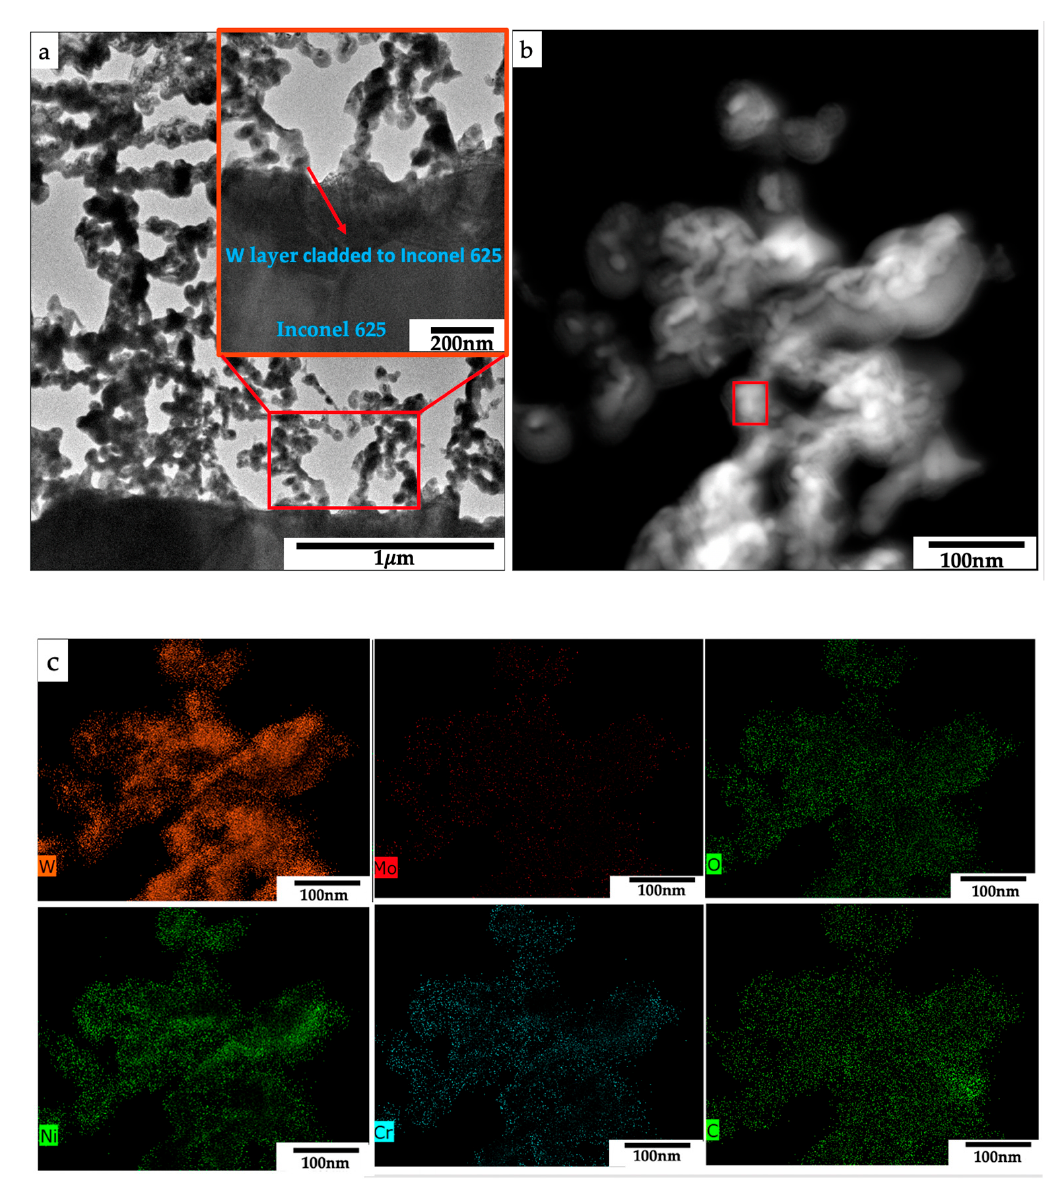
Figure 6. ( a ) TEM micrographs of Sample C2 showing sintered nanostructure and the cladded W nanostructures to the Inconel 625 substrate; ( b ) STEM micrograph of W network at higher magnification; ( c ) STEM-EDS elemental mapping of sample C2.